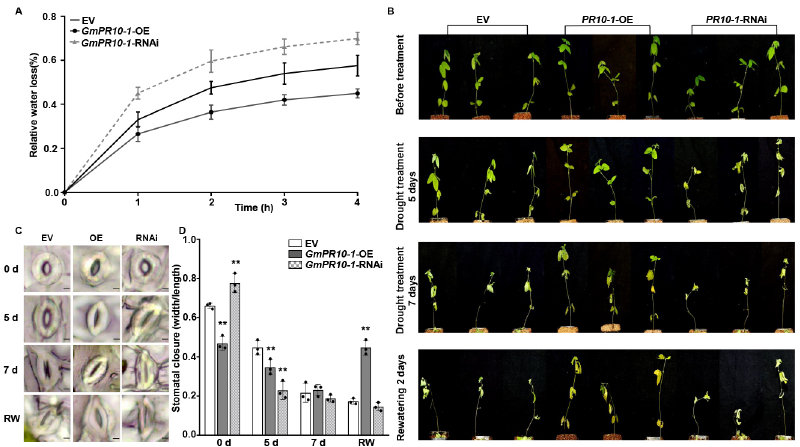
Figure 5. GmPR10-1 improves the drought tolerance in composite soybean plants with transgenic hairy roots. ( A ) The relative water loss of detached leaves (the second trifoliate leaves from the top) from EV, GmPR10-1- OE, and GmPR10-1- RNAi composite soybean plants with transgenic hairy roots. Transgenic soybean hairy roots of the same length (~10 cm) were selected, transferred to new pots (soil moisture contents in the pots were kept constant), and incubated for 3 days before the start of the drought treatment. ( B ) Phenotypes of EV, GmPR10-1- OE, and GmPR10-1- RNAi composite soybean plants with transgenic hairy roots that were exposed to drought stress for 0, 5, and 7 days and re-watered for 2 days. ( C , D ) Stomatal aperture of the second trifoliate leaves from the top of EV, GmPR10-1- OE, and GmPR10-1- RNAi composite soybean plants with transgenic hairy roots that were treated with drought for 0, 5, and 7 days and re-watered for 2 days (bars = 20 µ m). ( C ), and statistical analysis of the stomatal apertures of each line. ( D ). The experiments were performed on three biological replicates, each with three technical replicates, and were statistically analyzed using Student’s t -test (* P < 0.05, ** P < 0.01). The bars indicate the standard deviation of the